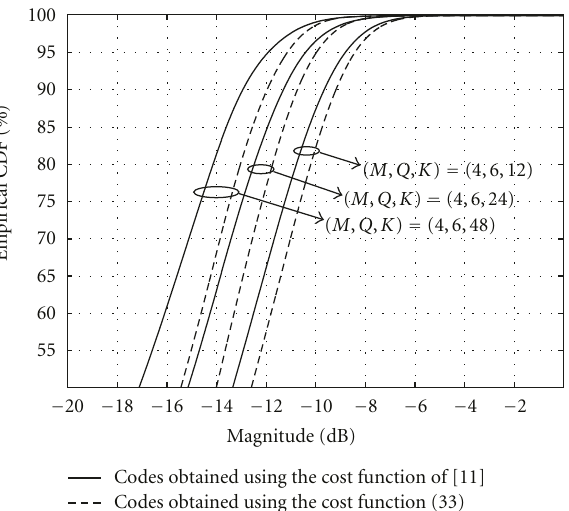
Figure 10: Empirical CDF of | Ω ( τ , ν , f , f (cid:6) ) | for the codes obtained with two di ff erent cost